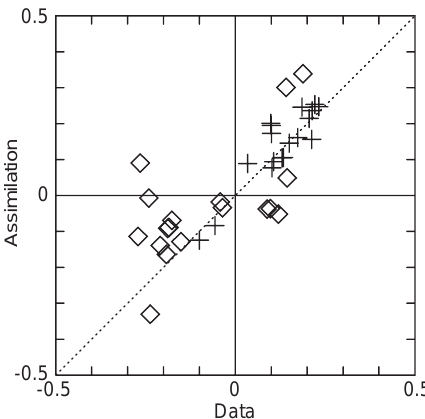
Fig. 7. Scatter plot of the along-section ( crosses ) and cross-section ( diamonds ) gradients of temperature at di(cid:128)erent levels obtained from the data taken on the triangular shaped track in 1990. ‘‘ Assimilation ’’ values are taken from the solution pattern. ‘‘ Data ’’ values are obtained by the direct linear fit of the data